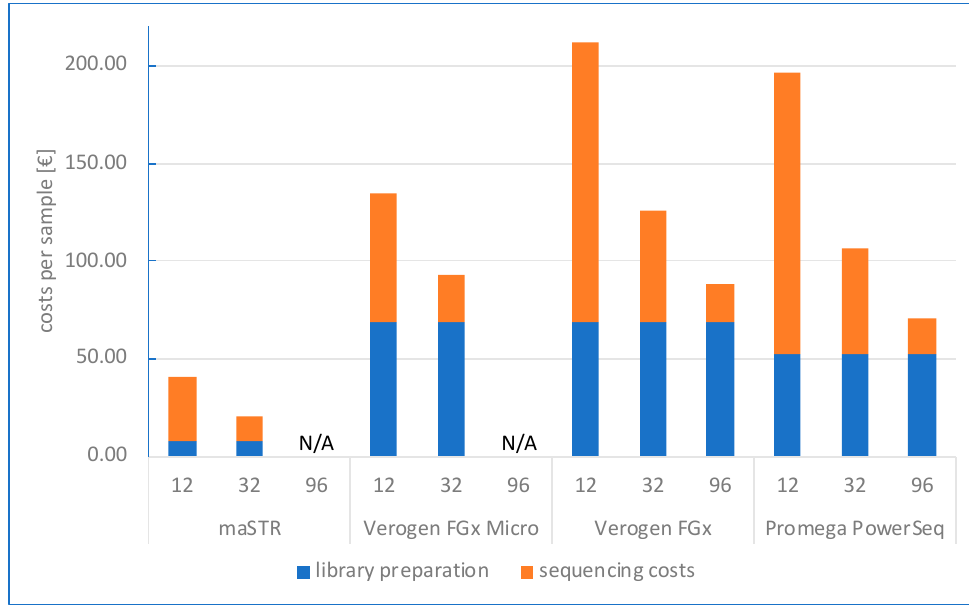
Figure 5. Sequencing costs, expressed as costs in EUR per sample, for the maSTR assay and three commercial, Illumina-based forensic NGS assays (Verogen’s MiSeq FGx Reagent Micro Kit and MiSeq FGx Reagent Kit, and Promega’s PowerSeq 46GY System) calculated for throughputs of 12, 32 or 96 samples, based on list prices. Please note that for maSTR and Verogen MiSeq FGx Reagent Micro Kit 96 samples are not applicable (N/A). Stacked bars represent total costs per sample, with blue and orange bars representing the proportional contribution of costs for sequencing library preparation and for sequencing reagents including flow cells, respectively.